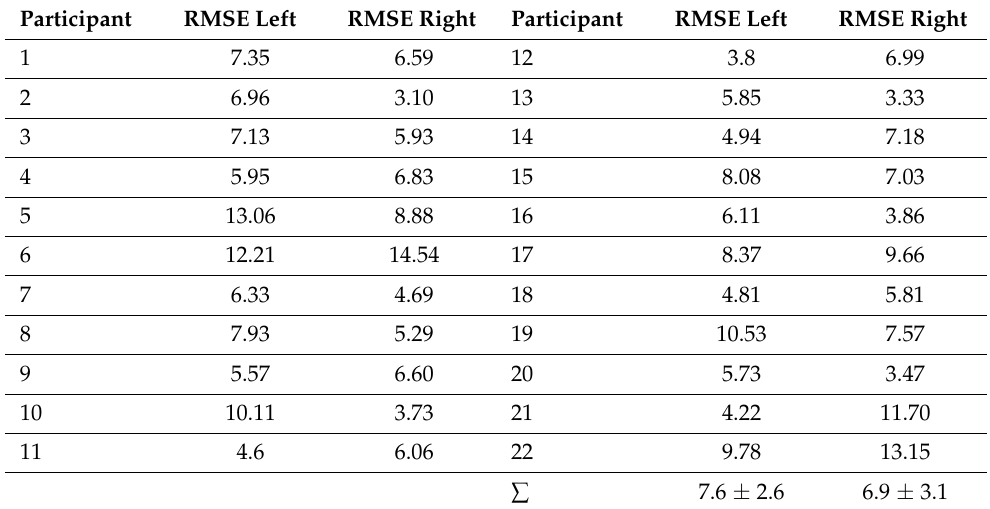
Table 1. Root Mean Squared Error for each individual (sofigait vs. Vicon) in degree ( N = 22 participants). Participant RMSE Left RMSE